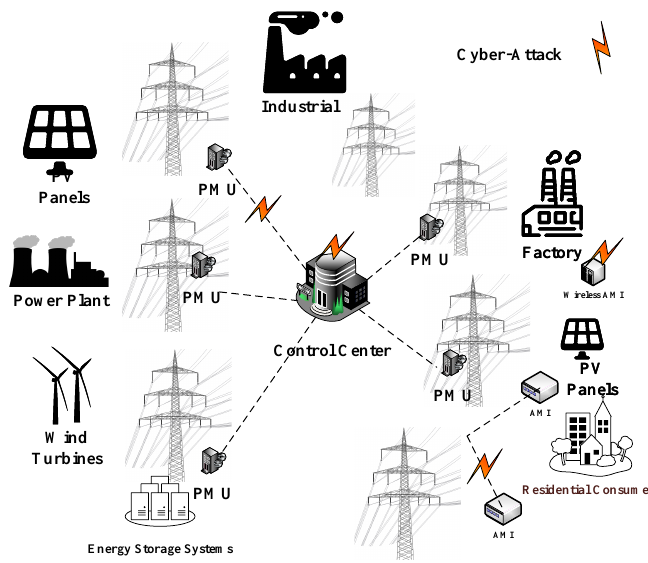
Figure 1. Cyber threats in a smart